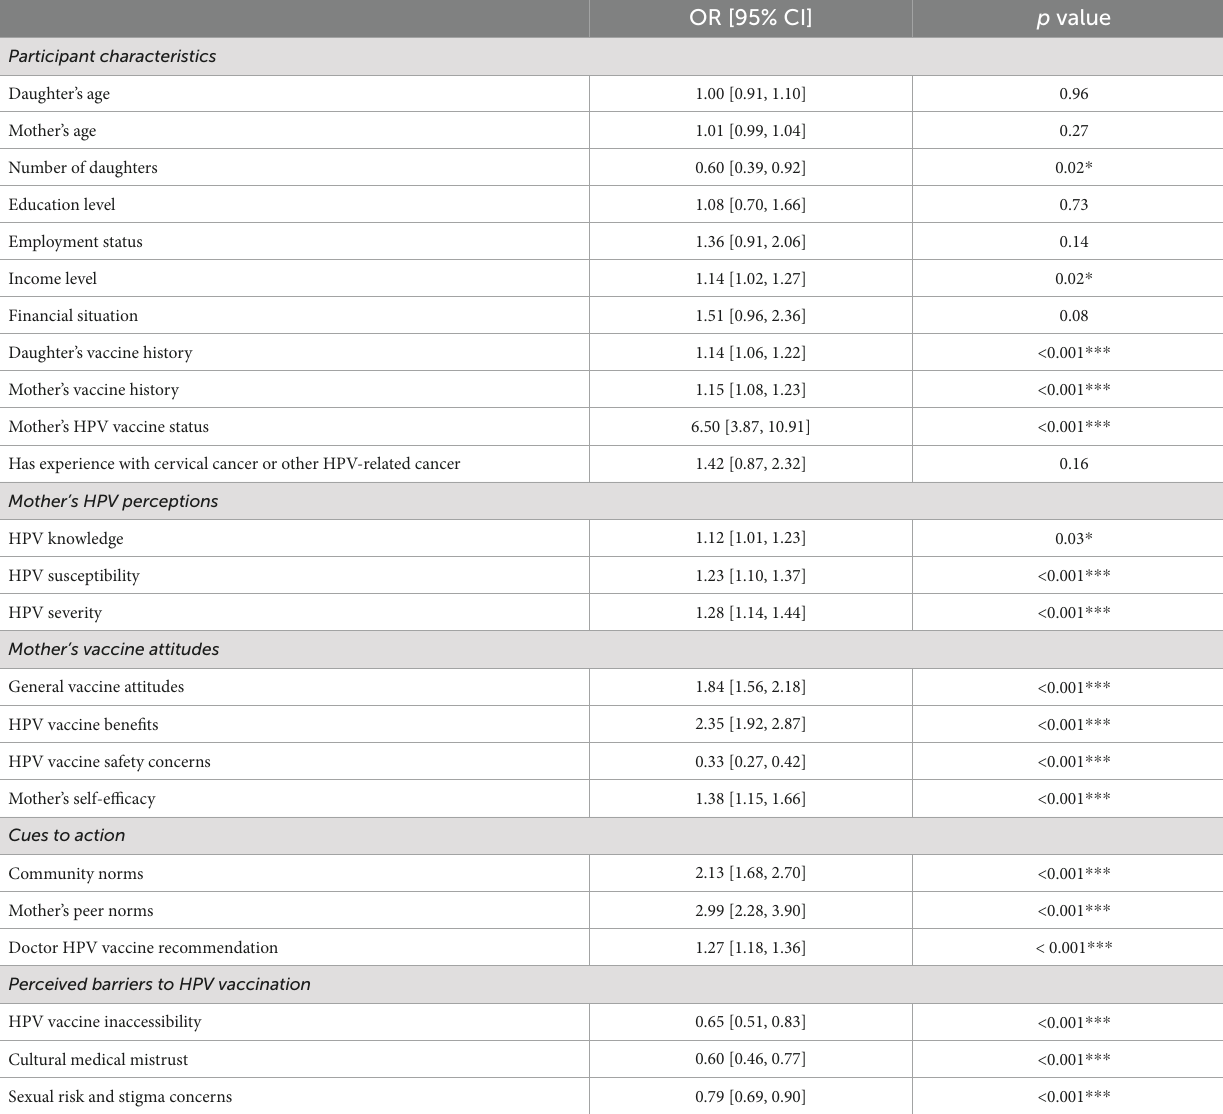
TABLE 3 Bivariate associations between determinants of HPV vaccine intentions and HPV vaccine